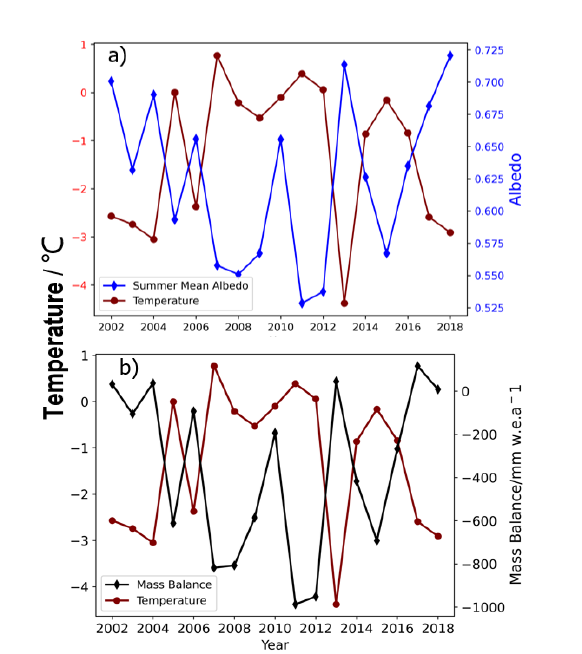
Figure 3. The whole glacier mean temperature (left axis), net annual galacier surface mass balance (right axis of (b)), and the interpolated average albedo (right axis of (a)) for White Glacier for the period 2002 to 2018.